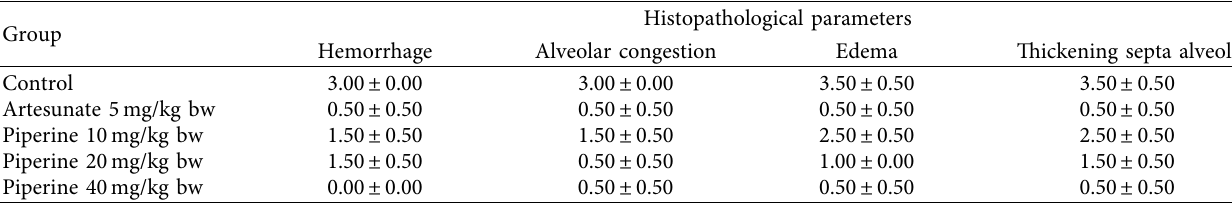
Table 1: Semiquantitative analysis of lung histopathology in the curative test.